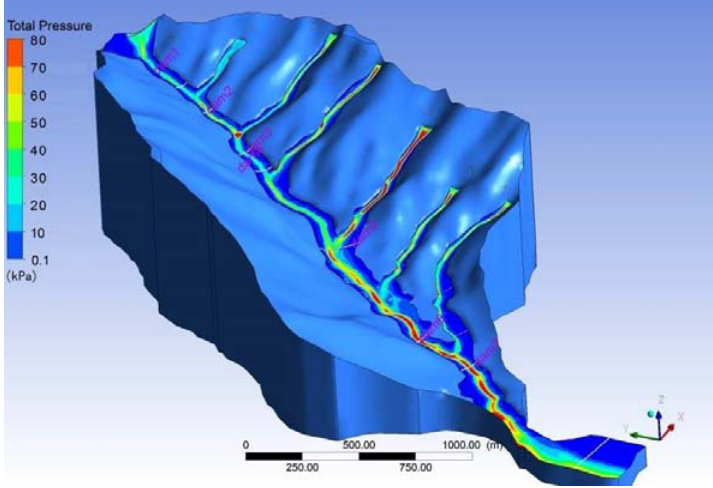
Figure 7. Debris flow pressure nephogram on the riverbed (time = 1634.2 s).